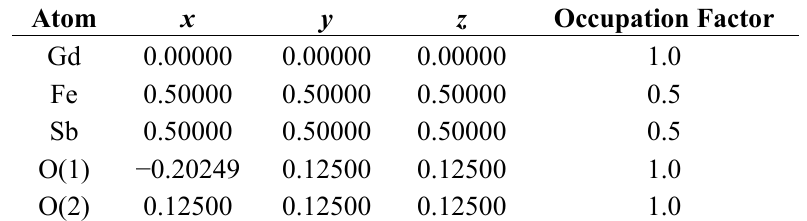
Table 3. Structural parameters of Gd 2 FeSbO 7 prepared by solid-state reaction method. x , y and z refer to the position coordinates of different atoms in one unit cell, respectively.